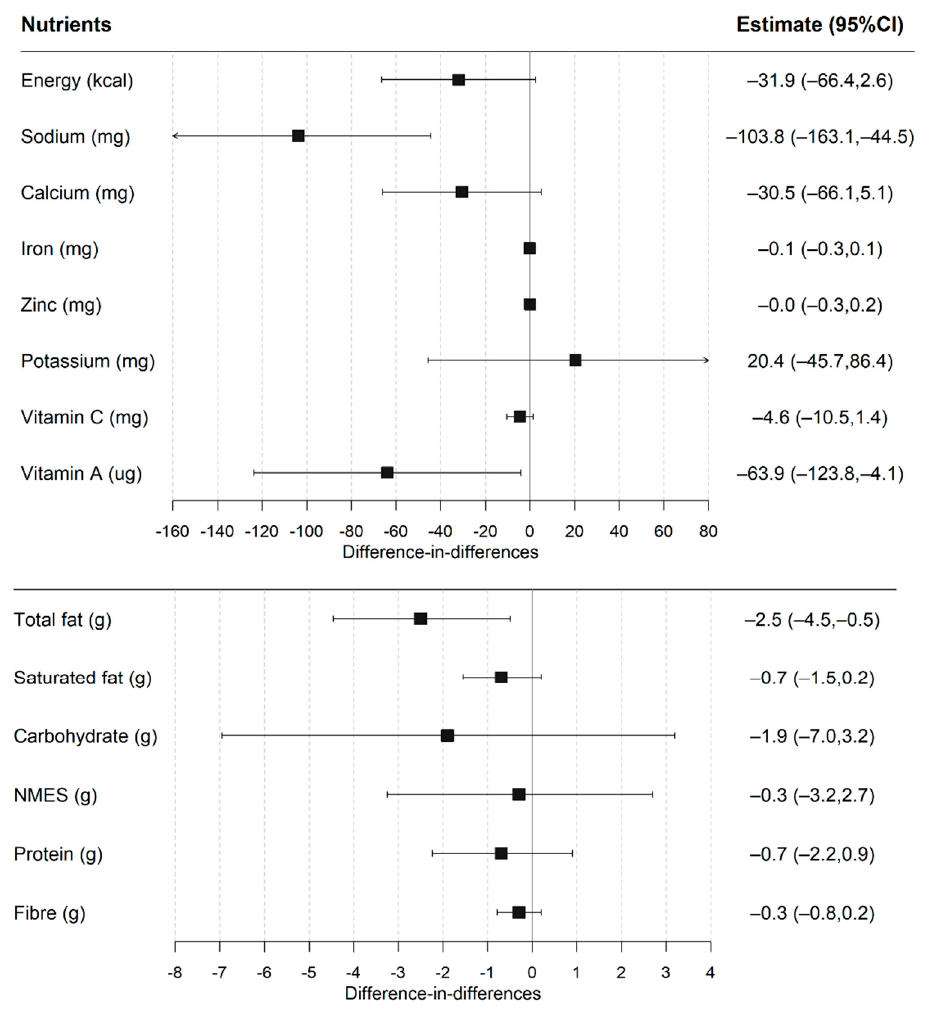
Figure 3. Difference-in-differences estimates of UIFSM policy impact on lunchtime nutrient intakes. Note: NMES—non-milk extrinsic sugar. Linear regression adjusted for age, sex, ethnicity, household size, region, household income, IMD and total lunchtime intake. Pre/Post mean intakes of nutrients presented in Table S6.